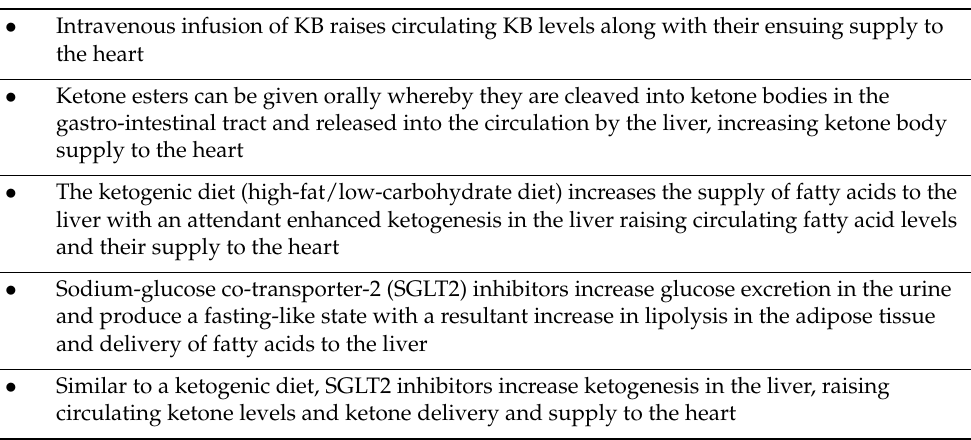
Table 1. Therapeutic and dietary strategies to enhance the delivery of ketone bodies (KB) to the